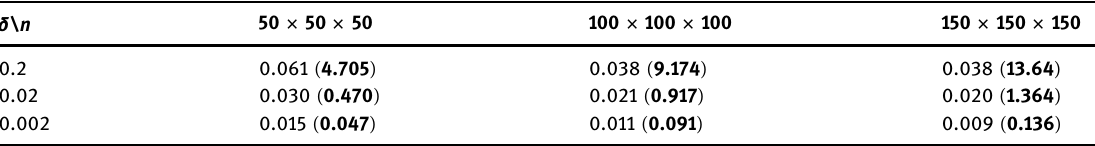
Table 3: l 2 - relative errors in the recovered gradients for Example 5.3 for several sample sizes n and noise levels δ . Numbers in parenthesis represent the relative errors computed from the noisy